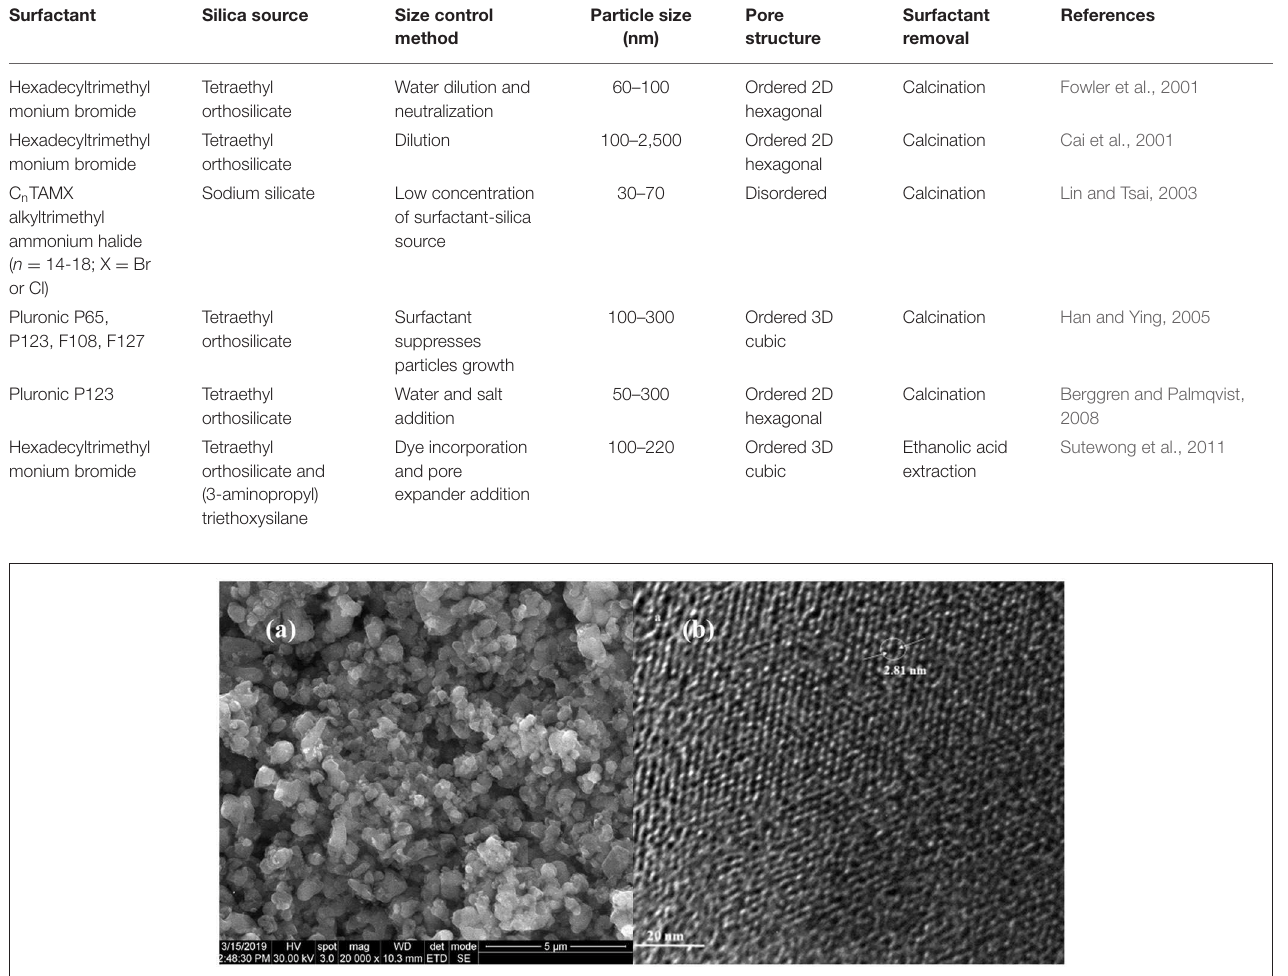
TABLE 1 | An overview of some synthesis methods for mesoporous silica nanomaterials. Surfactant